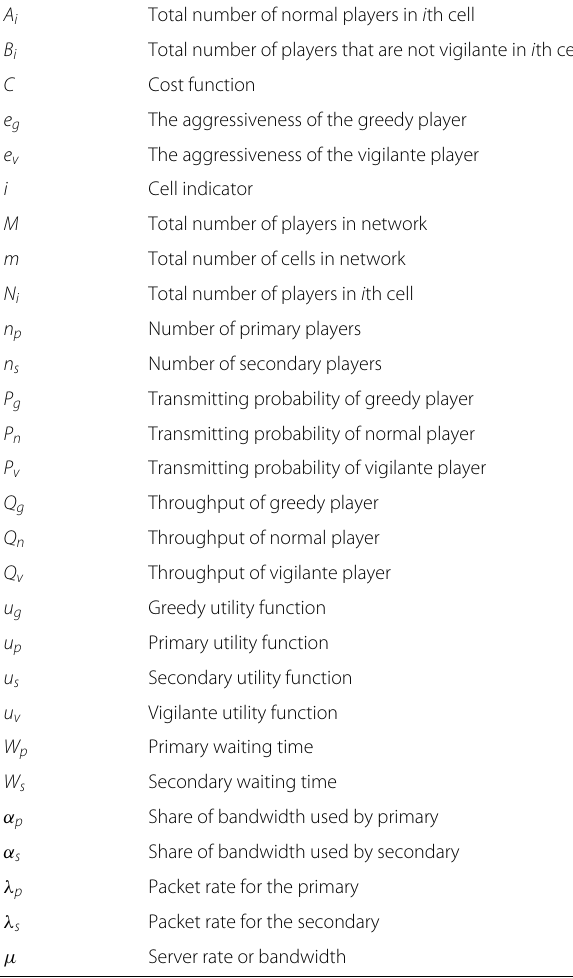
Table 1 Summary of variables used in